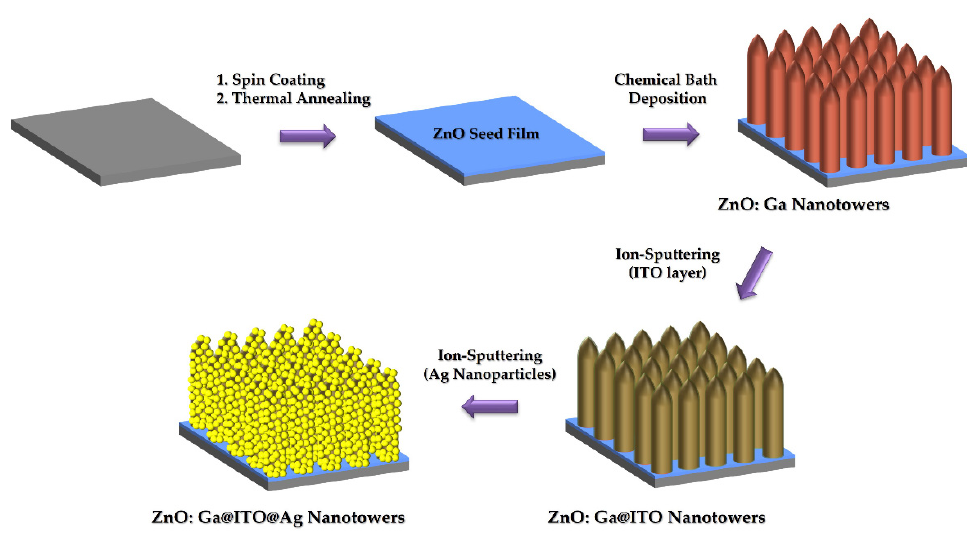
Figure 1. Schematic representation of the synthesis procedure of ZnO: Ga@ITO@Ag nanotowers.